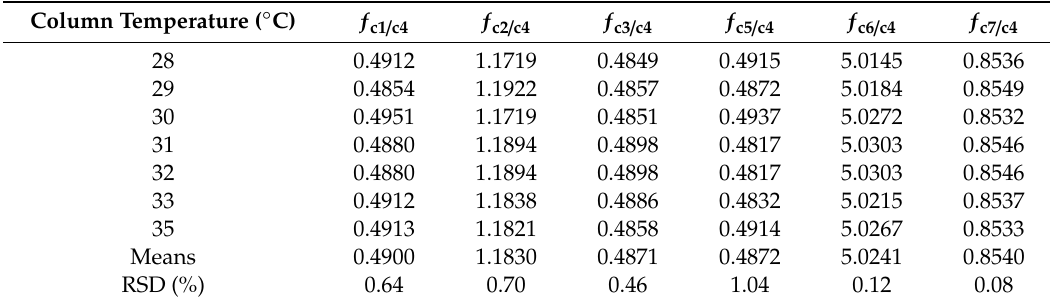
Table 8. RCFs in di ff erence column temperatures.